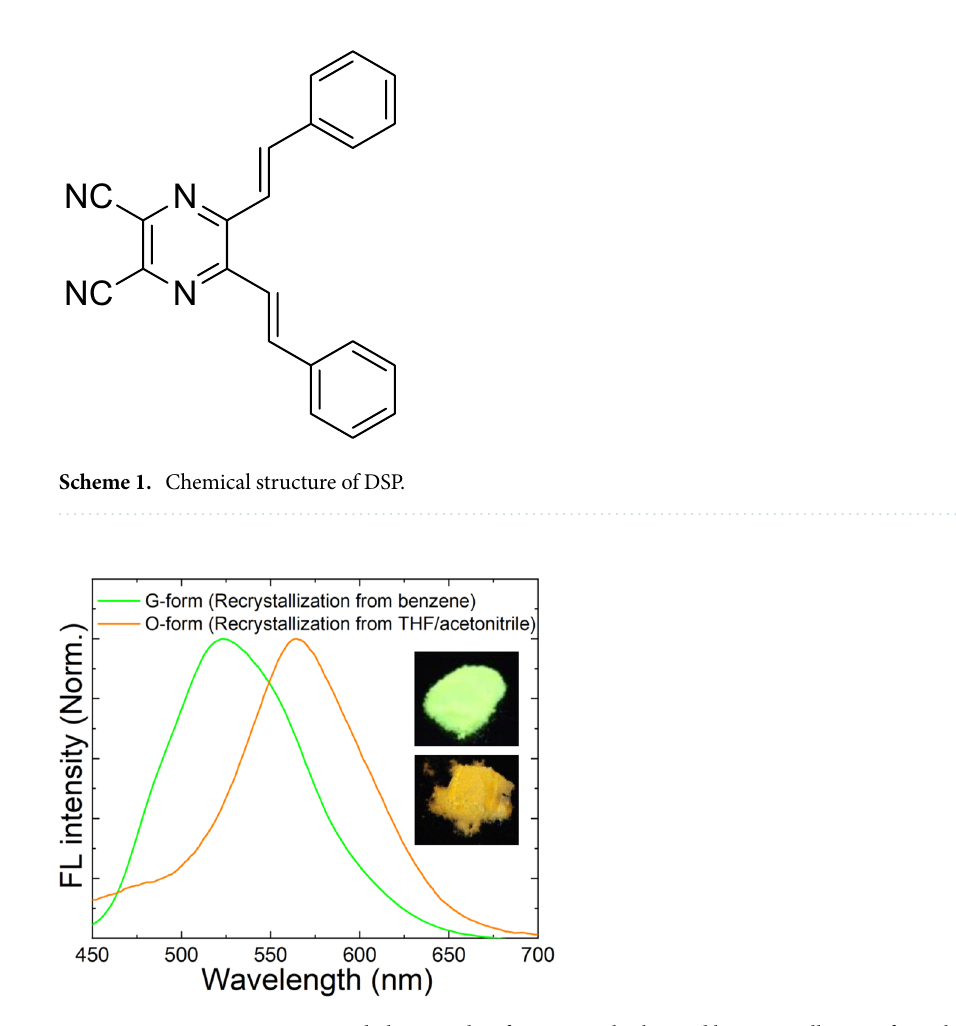
Figure 1. FL emission spectra and photographs of DSP crystals obtained by recrystallization from the 1:1 (v/v) mixture of THF/acetonitrile (O-form) and benzene